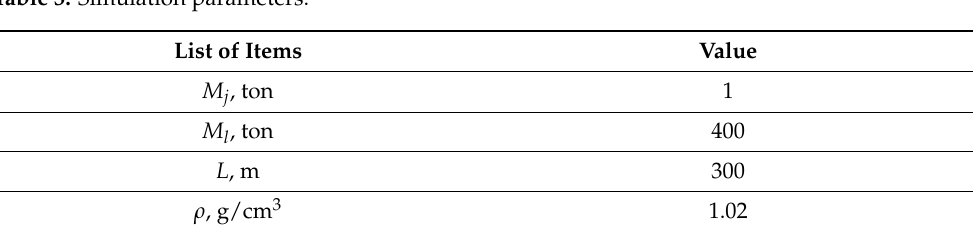
Table 3. Simulation parameters.